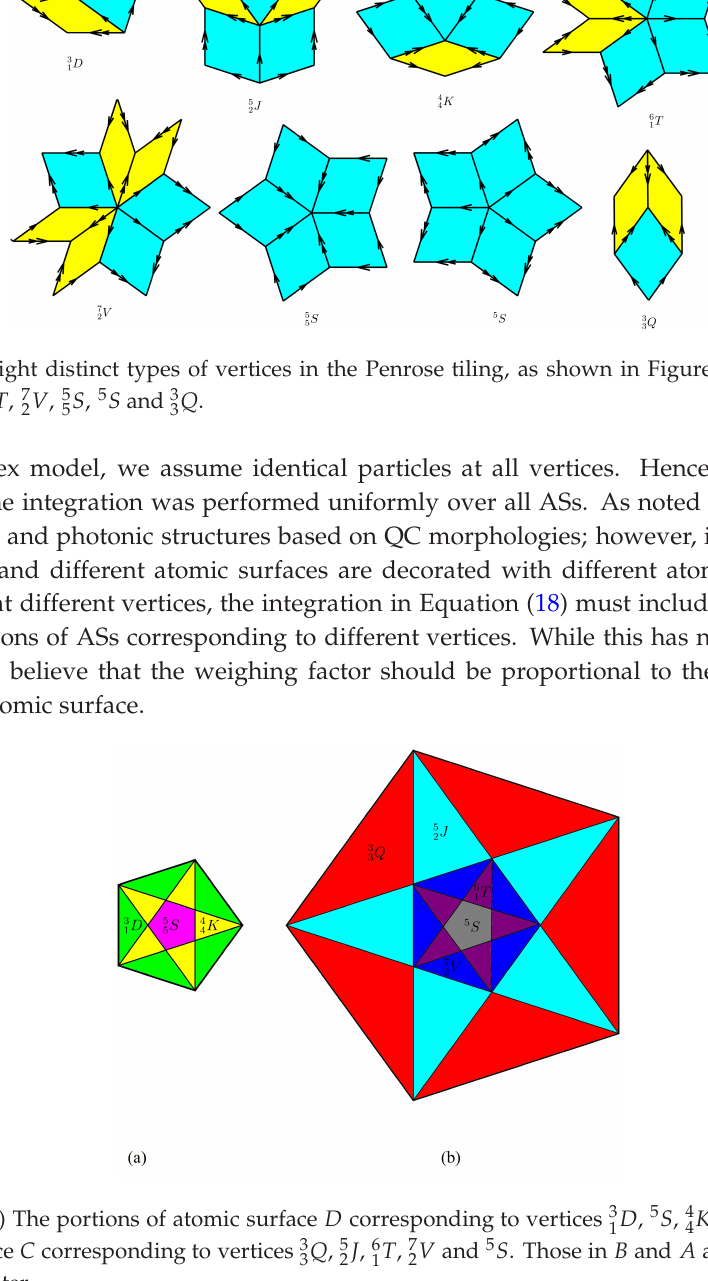
J , 6 T , 7 V and 5 S . Those in B and A are related by an Q , 5 2 2 3 1